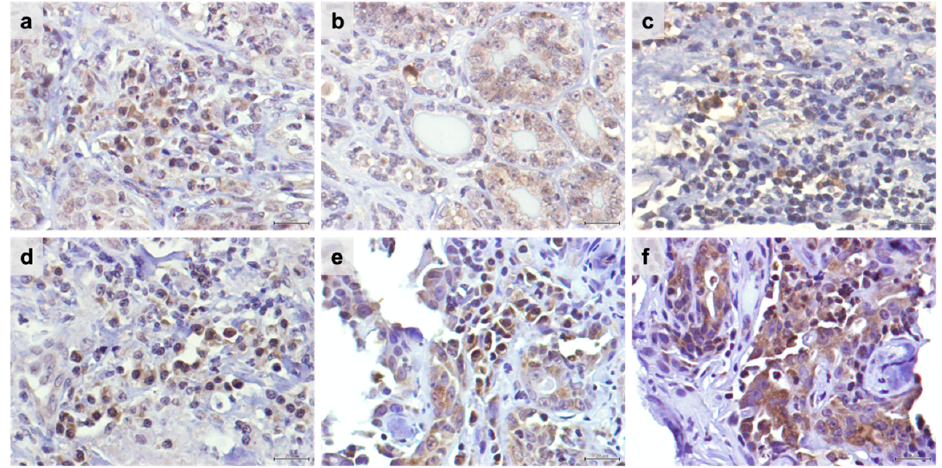
Figure 1. TIM-3 is highly expressed in tumor-infiltrating lymphocytes (TILs) and cancer cells in feline mammary carcinoma. Nuclei were stained by Harris hematoxylin in blue and TIM-3-positive cells in brown. ( a ) Representative TIM-3 immunostaining of intra-tumoral TILs with a moderate staining